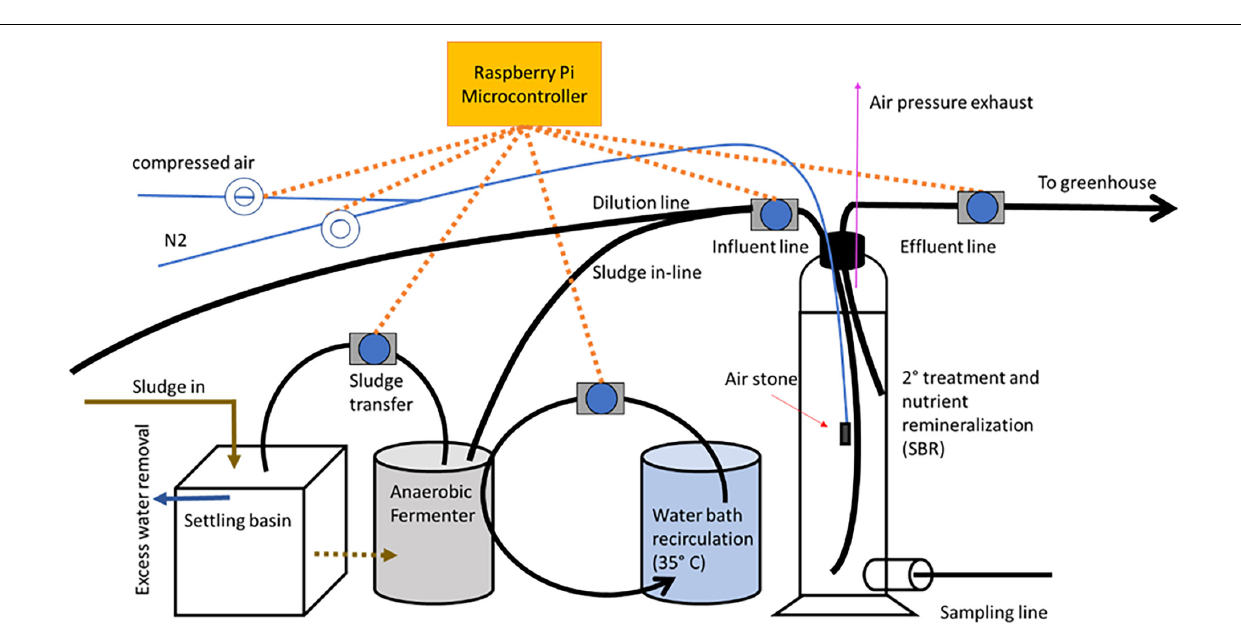
FIGURE 2 | An overview of the solid waste treatment